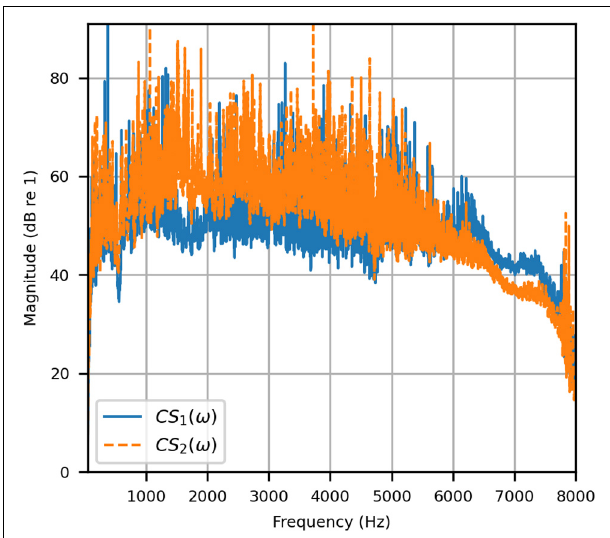
FIGURE 5 | Anechoic chamber: Channel separations for a target impulse to the left (blue solid) and right (red dashed) microphones.